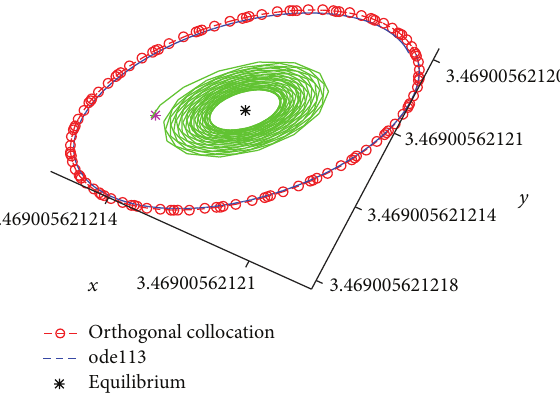
Figure6:Codimension2(see(48)), 𝑠 = 1 ,Region 𝑅 1 .Unstablecycle and behavior of inner orbits for (𝜎,𝑐,𝑏,𝑏 2 ) = (2.2,2.4871, 5.47,−1) ( 𝑏 𝑐𝑟 = 5.3476 ) (pink marker marks the beginning). Stable equilib- rium (black marker): (3.469, 3.469, 2.2) . ode113: Adams-Bashforth- Moulton PECE solver of orders 1 to 12